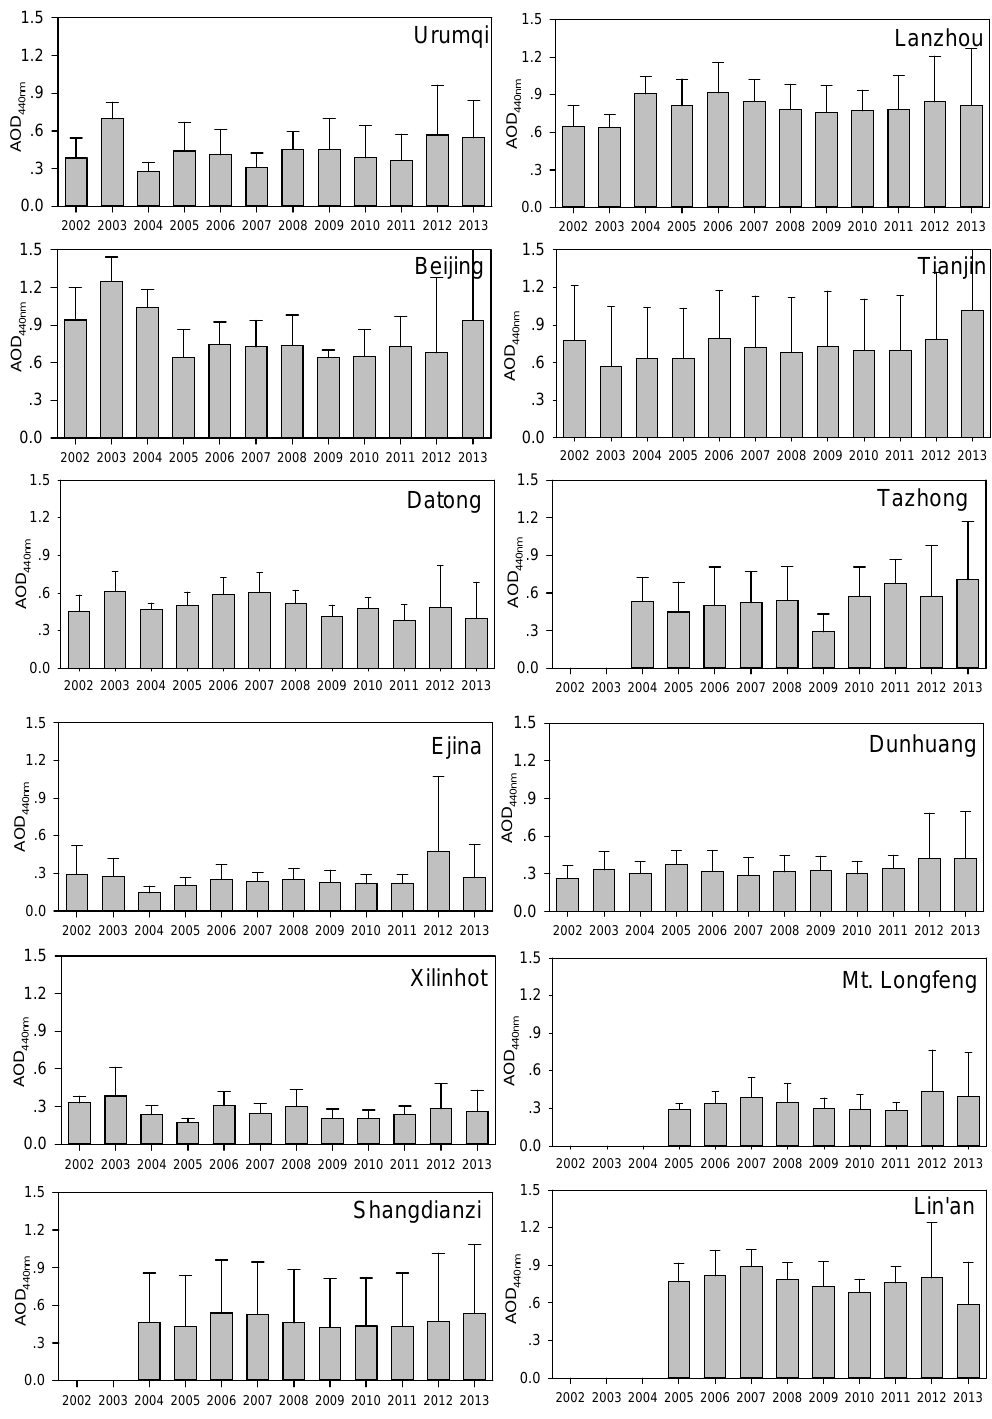
Figure 16. Annually averaged AODs at 440nm for the 12 long-term CARSNET sites.